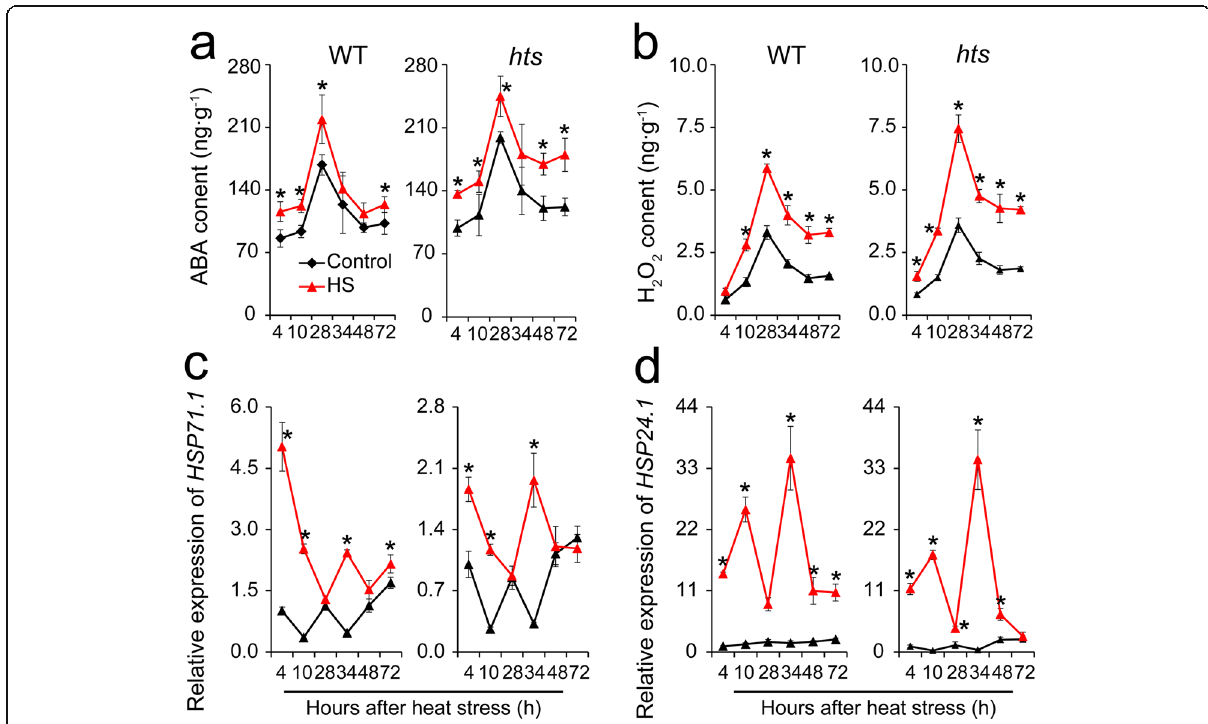
Fig. 4 Changes in of ABA, H 2 O 2 , and heat shock proteins in leaves of rice plants under heat stress. a , ABA content; b , H 2 O 2 content; c , Relative expression level of HSP71.1 ; d , Relative expression level of HSP24.1 . Vertical bars denote standard deviations ( n = 3). A t -test was conducted to compare the differences between control and heat stress within a cultivar on the same day. * denotes P <